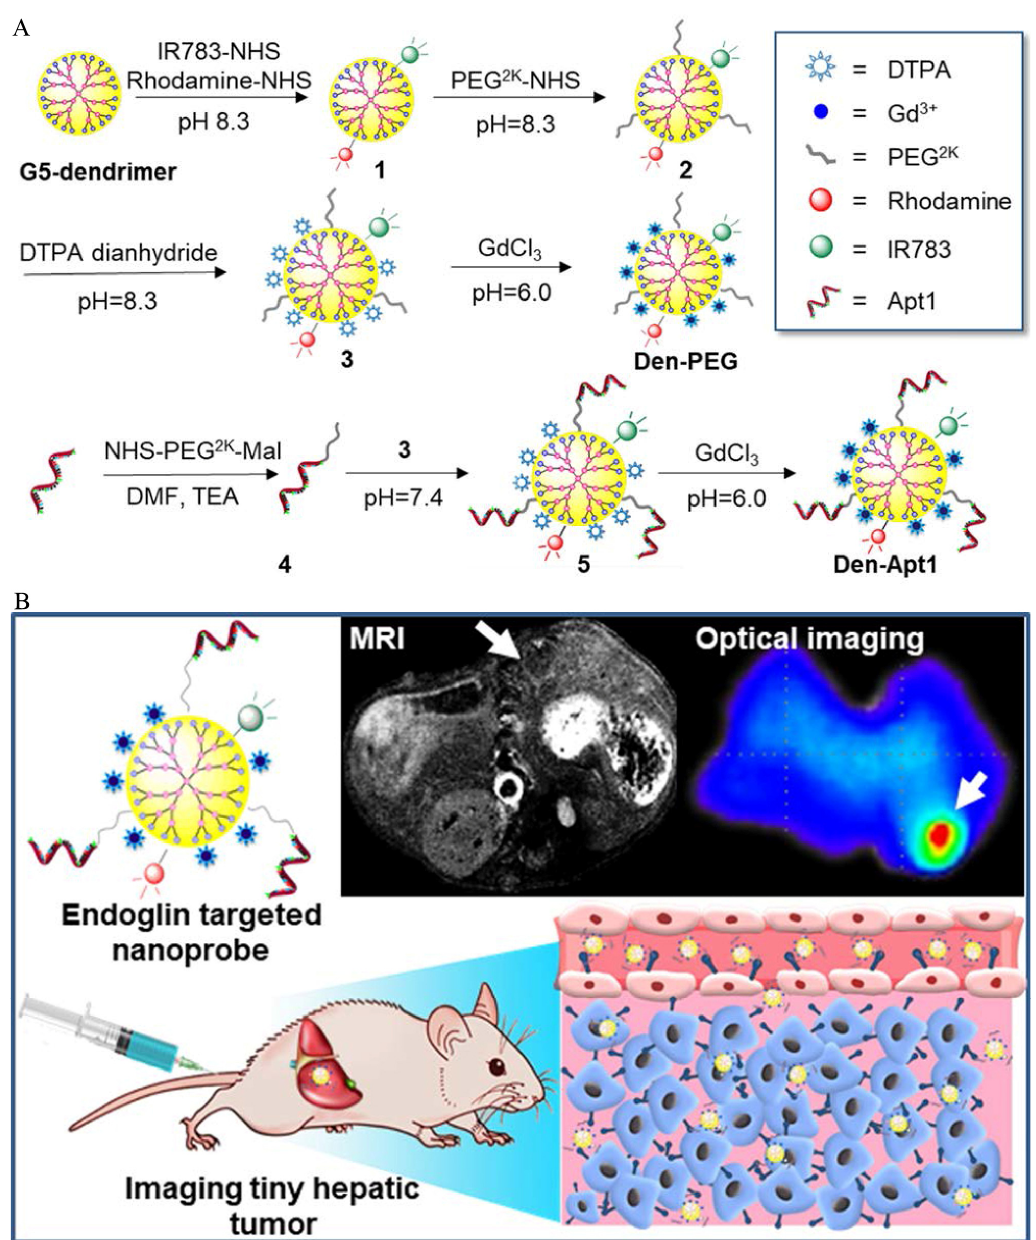
Figure 11. ( A ). Construction of endoglin-targeted MR/optimal dual-mode molecular imaging probe using aptamer as ligand. ( B ). The as-synthesized nanoprobe successfully achieved MR/optimal dual modal imaging in vivo by targeting endoglin overexpressed on the surface of HCC cells and endothelial cells of neovasculature. Reproduced with permission Ref. [80]. Copyright 2018 American Chemical